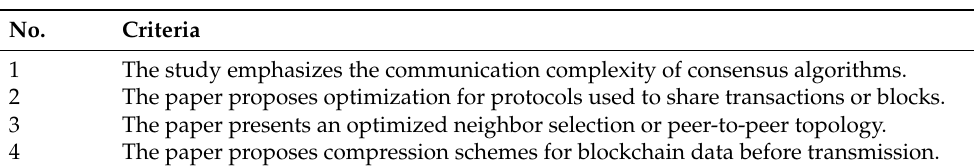
Table 4. Inclusion